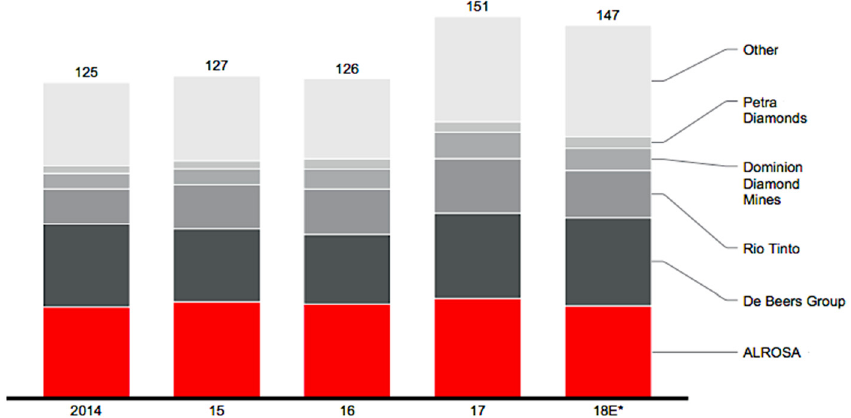
Figure 3. Major producers of rough diamonds in millions of carats (2014–2018). Notes: The figure presents major diamond mining companies and producers of rough diamonds in millions of carats in 2017 . Source : (Bain and Company, Antwerp World Diamond Center 2018).